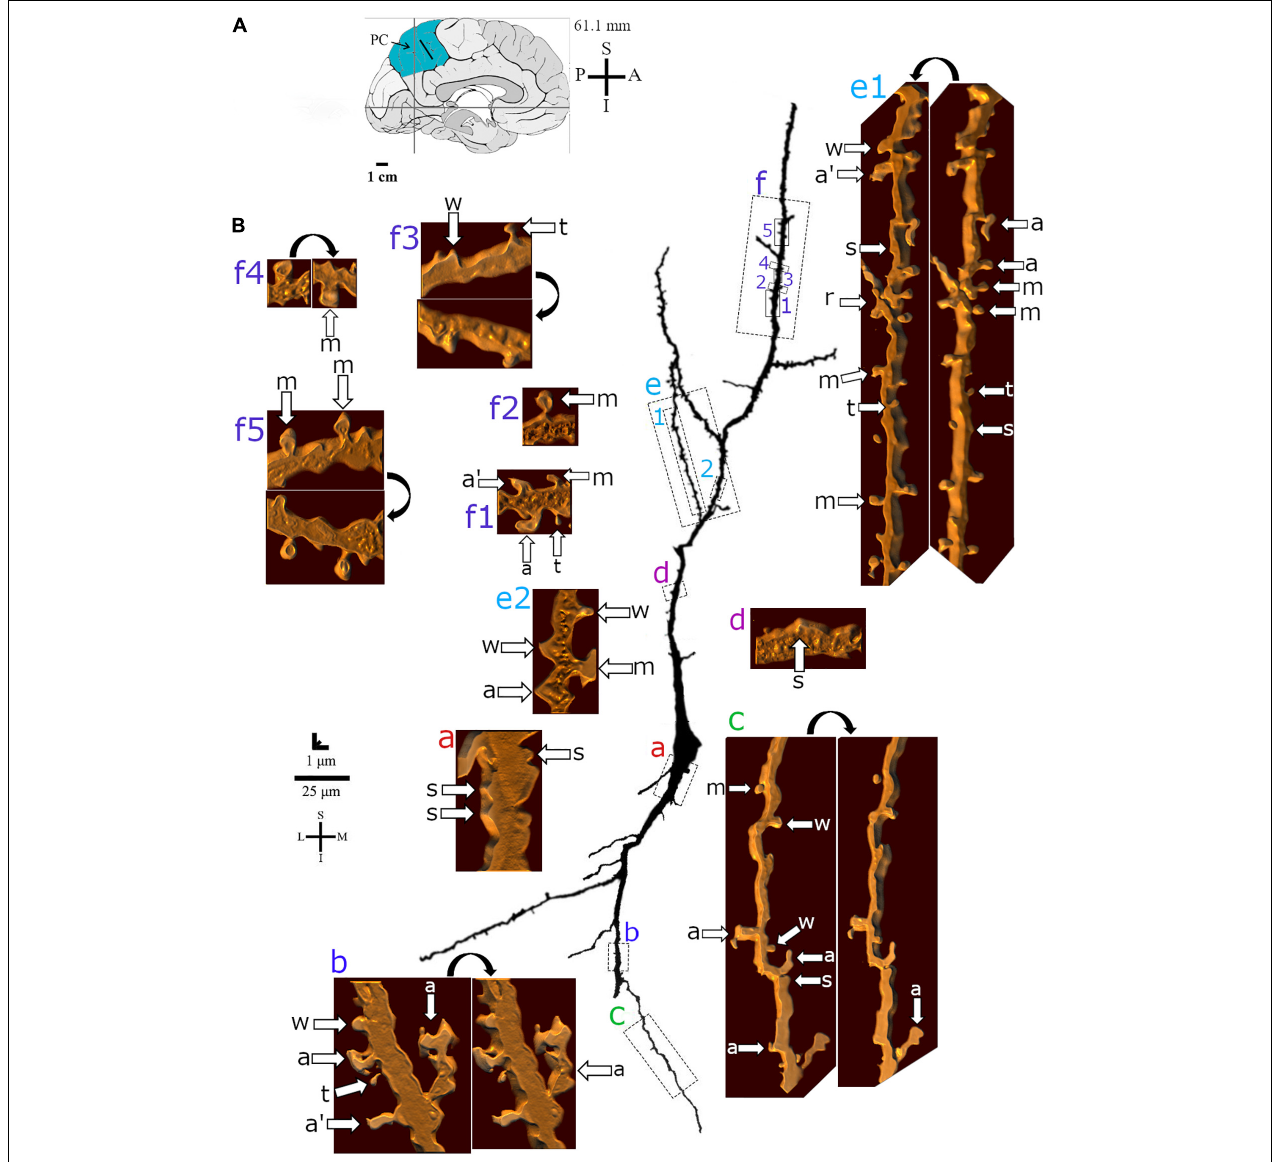
FIGURE 5 | (A) Left: Schematic drawing of the medial view of the human brain showing the location of the precuneus (PC, highlighted in blue), central region, 61.1 mm posterior to the midpoint of the anterior commissure. Adapted from Mai et al. (2008, 2016). (B) Two-dimensional (for the overall shape) and 3D (for the dendritic and spine details) image reconstructions of serial brightfield photomicrographs of a Golgi-impregnated spindle-shaped neuron from layer V in the human PC (pial surface at the top). Note the cell body shape, the main ascending and descending primary dendrites with a straight course and few ramifications. Proximal to distal dendritic segments (identified by colored letters from “a” to “f”) were sampled and their spines are shown at higher magnification in the adjacent corresponding boxes. Note the distribution of low to moderate density of spines as well as the variety of their shapes. Spines were classified as stubby (s), wide (w), thin (t), mushroom (m), ramified (r), with a transitional (t), or atypical aspect (a). Spine types are indicated by arrows at different rotating angles. An apostrophe with the corresponding spine indicates the presence of a spinule. Image adjustment of contrast made with Photoshop CS3 (Adobe Systems, Inc., United States). Coordinates in (A,B) : I, inferior; L, lateral; M, medial; S, superior. Scale = 25 µ m for the 2D reconstruction and 1 µ m for the 3D